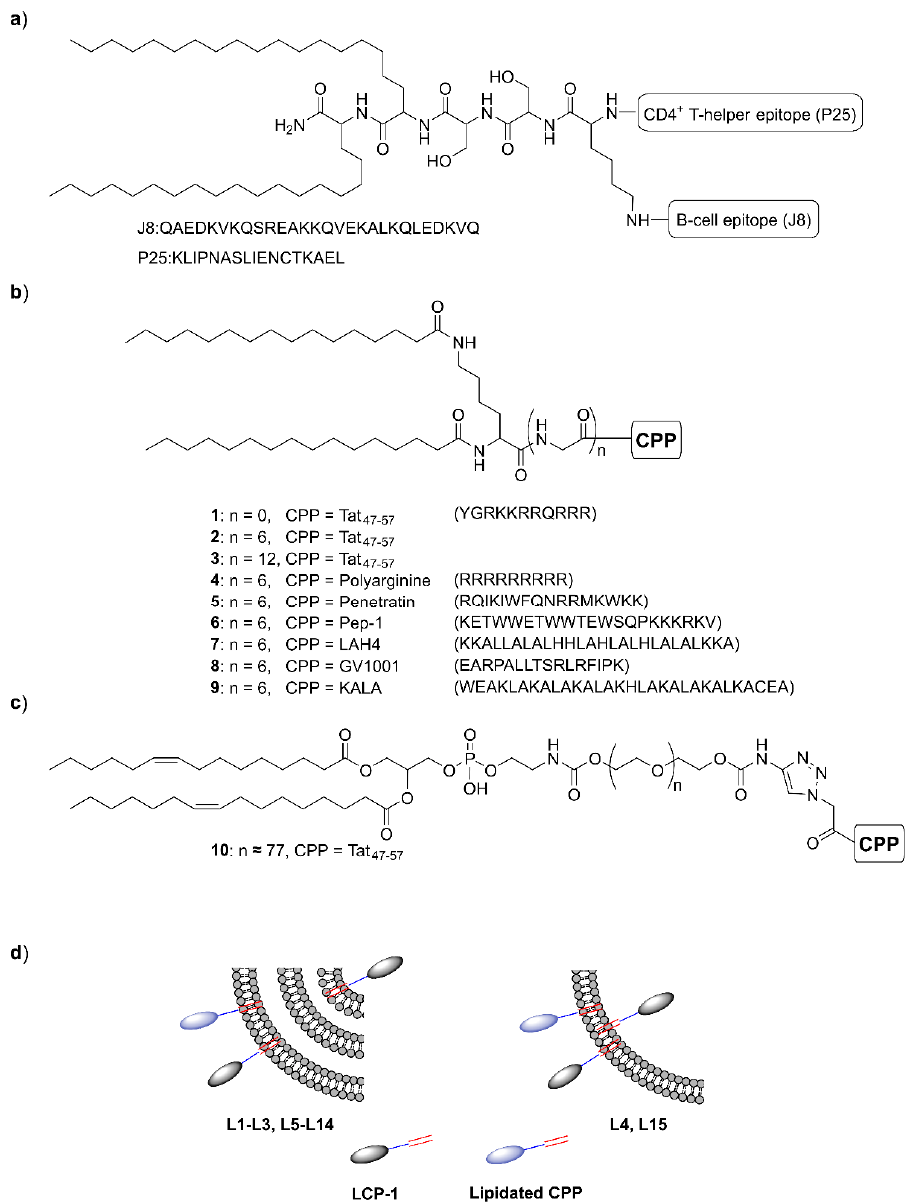
Figure 1. The CPP-liposome-based vaccine delivery system. ( a ) The chemical structure of LCP-1; ( b ) the chemical structure of 1–9 (lipidated CPPs); ( c ) the chemical structure of 10 (DOPE-PEG 3400 - Tat 47–57 ); ( d ) schematic representation of the multilamellar liposomes L1–L3, L5–L14 and unilamellar liposomes L4 and L15 (Table 1). Table 1. Composition and physicochemical characterization of LCP-1-loaded liposomes ( L1–L15 ). LCP-1-Loaded